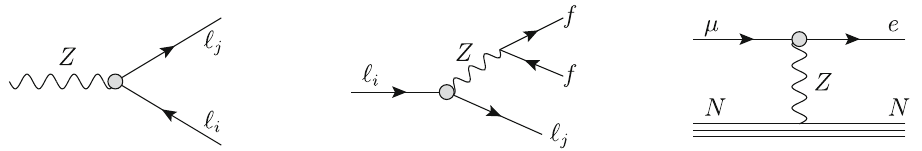
Fig. 1 Examples of tree-level diagrams where the same LFV vertex generating Z → (cid:2) i (cid:2) j induces low-energy processes such as (cid:2) i → (cid:2) j f f , with f = (cid:2), q , or μ - e conversion in nuclei